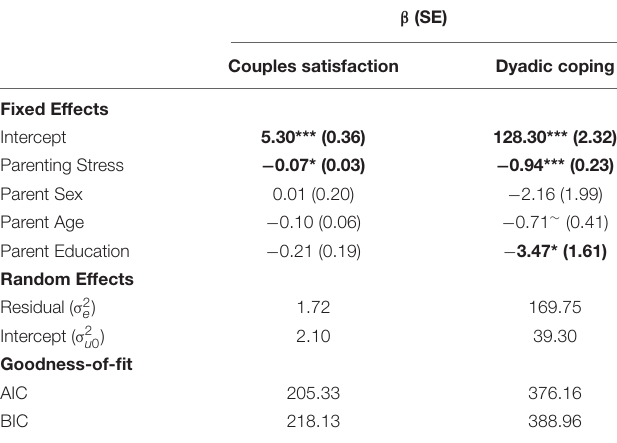
TABLE 6 | Multilevel model results for Aim 3 ( n =